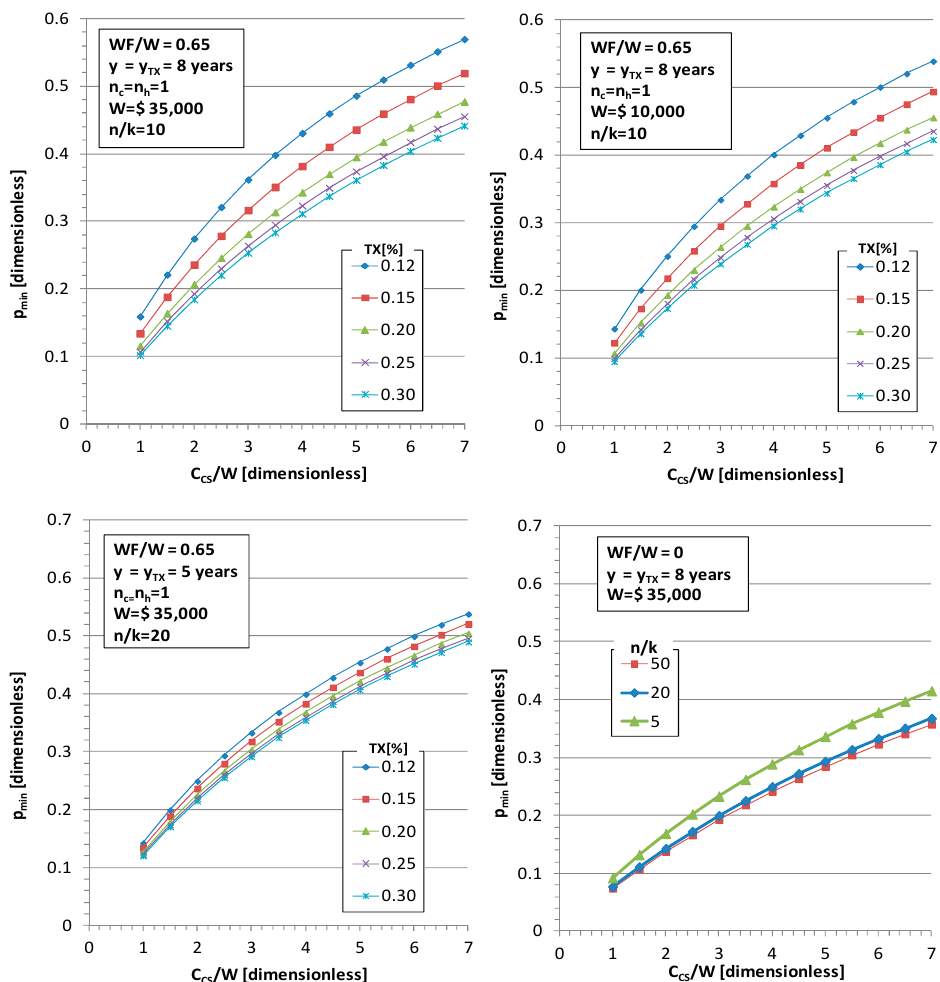
Figure 2. Minimum productivity pmin to support net replacement income WF.